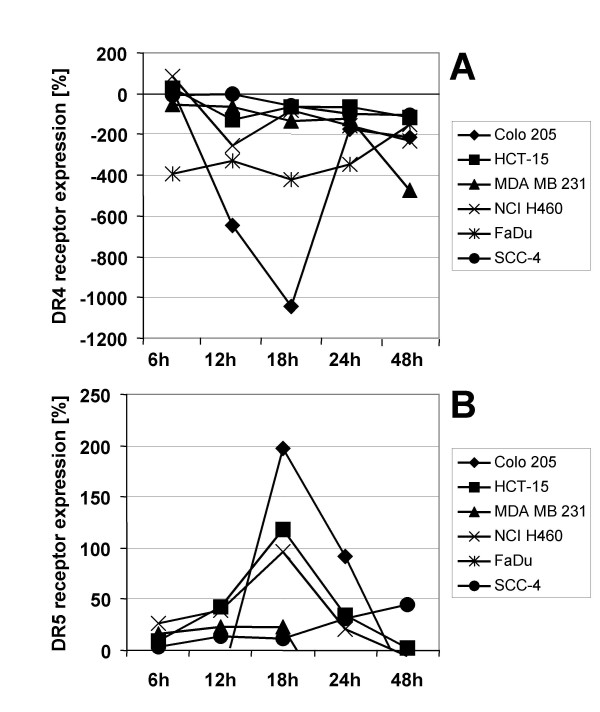
Surface expression of TRAIL receptors after irradiation with 10 Gy in six tumour cell lines. Quantification of receptor expression was performed 6 to 48 h after irradiation by FACS analyis using the Quantibrite™ evalution system from BD(Heidelberg, Germany) according to manufacturer's instructions. Data shown are from one representative experiment (n ≥ 3). A: Cell surface expression of R1/DR4 B: Cell surface expression R2/DR5